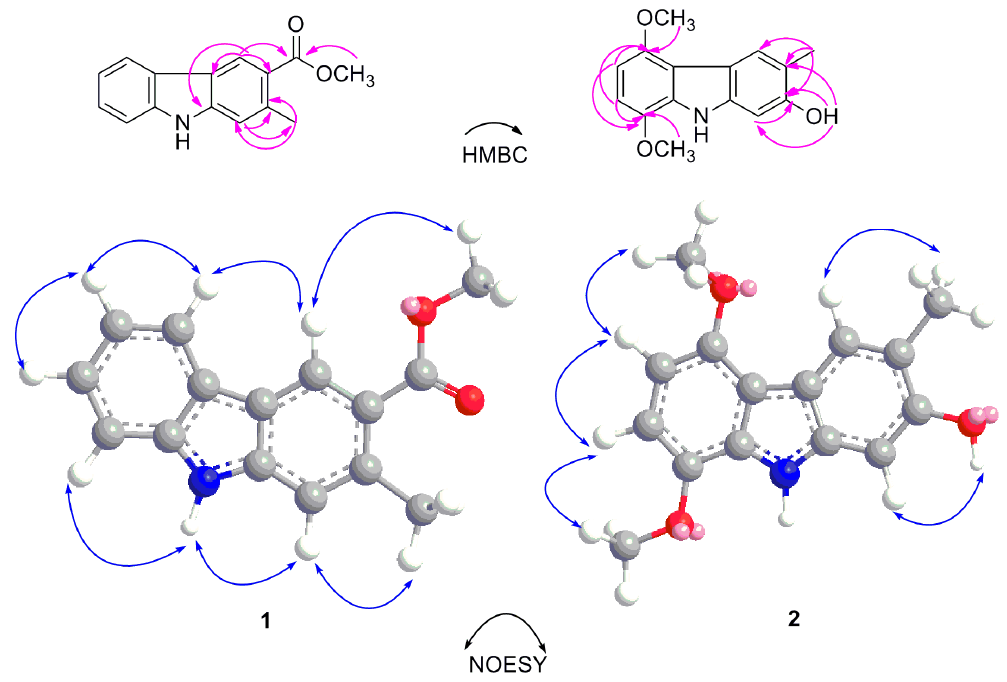
Figure 3. Key HMBC and NOESY correlations of 1 and 2.